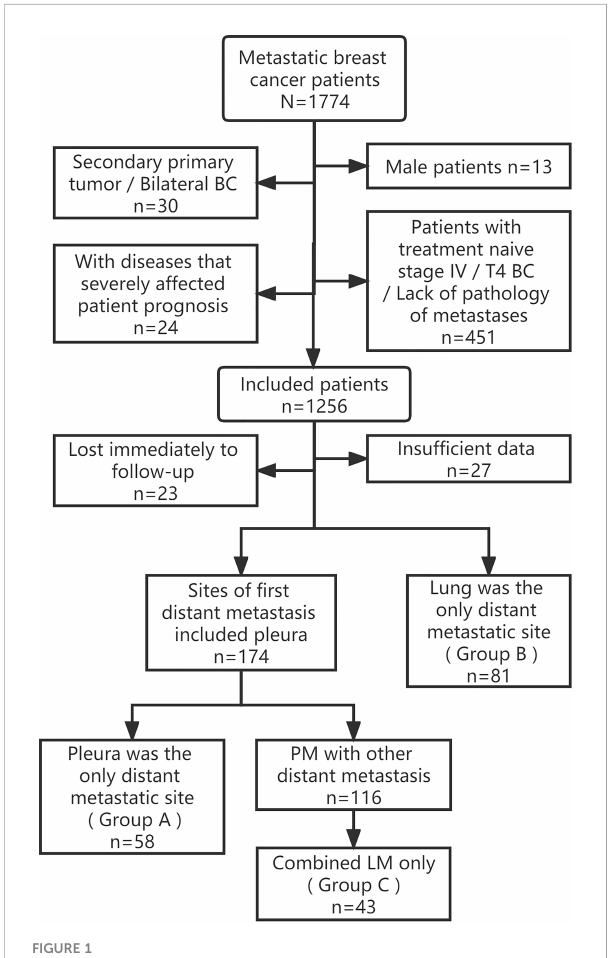
FIGURE 1 Flow chart of patient selection. BC, Breast cancer; PM, Pleural metastasis; LM, Lung